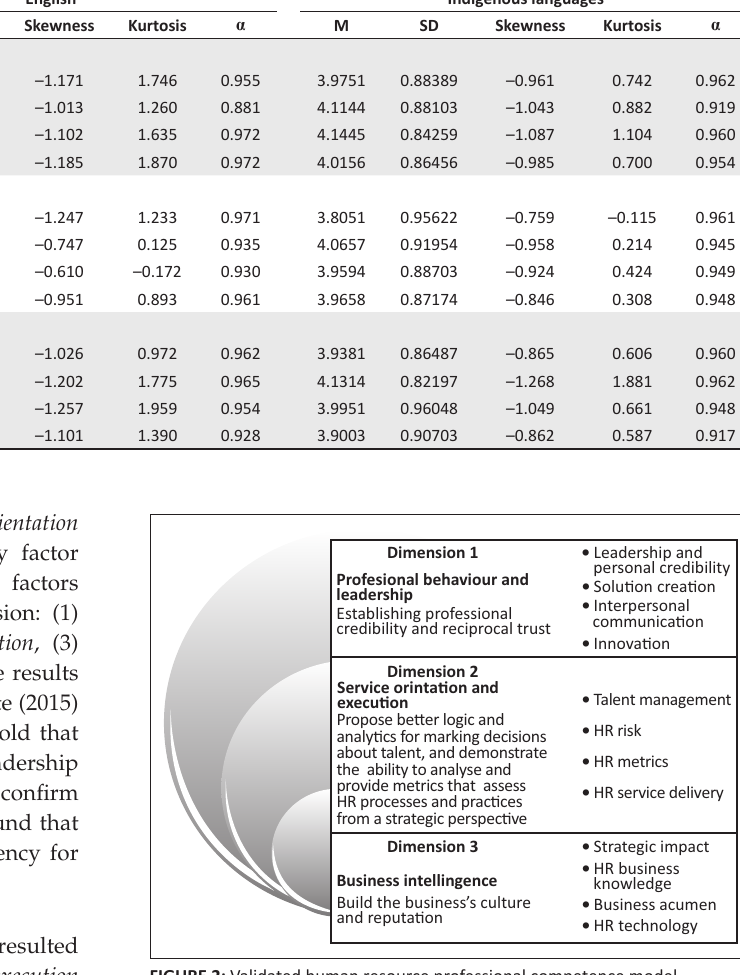
TABLE 4: Descriptive statistics of the HR Professional Competence Model. Factor